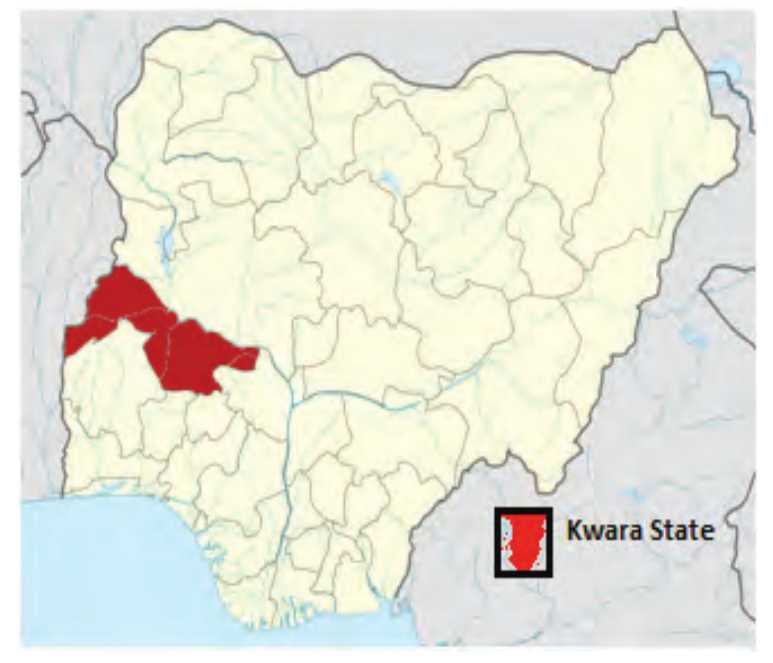
Figure 2. During a flood event in Ilorin Metropolis in